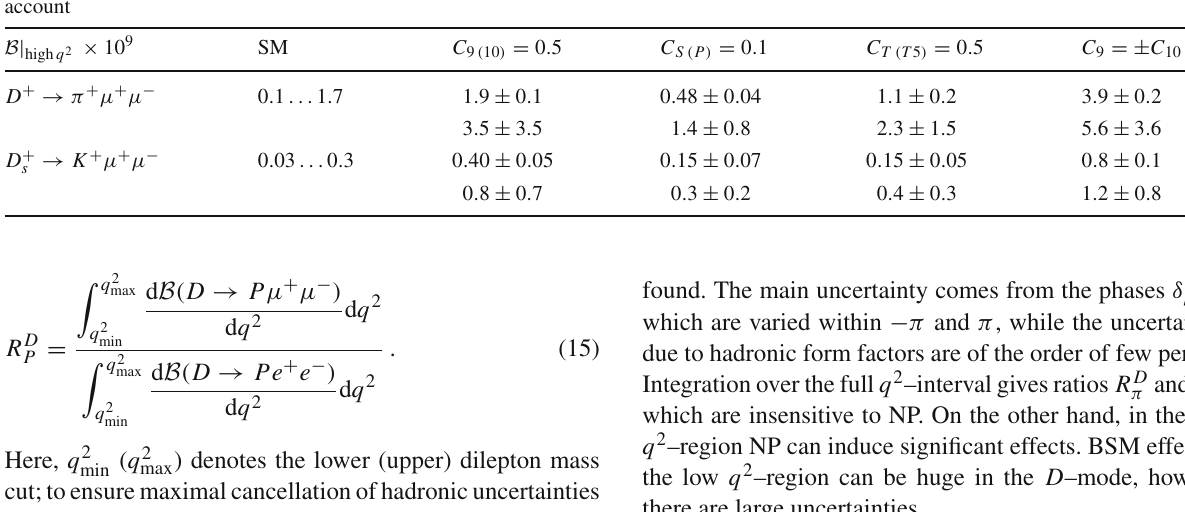
. 5 . . ]0 . 2 . 0 q 2 [GeV 2 ( (cid:3) ) 9